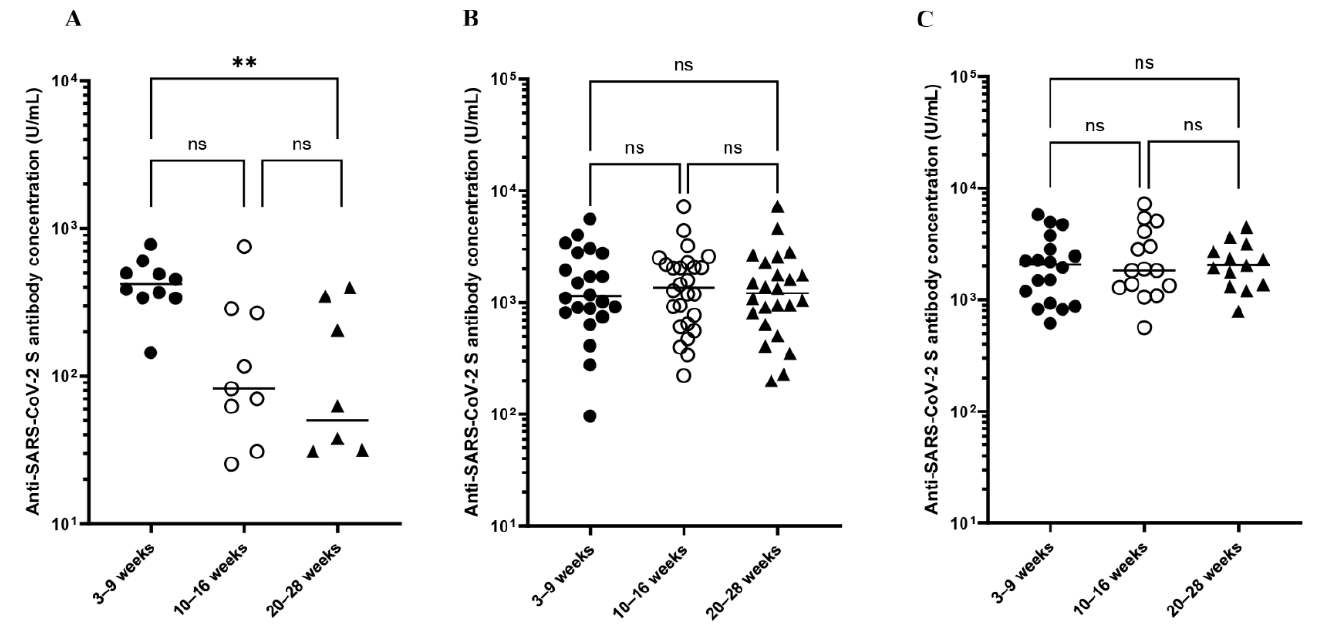
Figure 2. Anti-SARS-CoV-2 antibody concentrations (U/mL) at different time points after the initial two-vaccine series. ( A ) Antibody titers of patients treated with anti-TNF α decrease over time, and those at 20–28 weeks are significantly lower than those at 3–9 weeks. ( B ) Antibody titers of patients treated with non-anti-TNF α are sustained over time. ( C ) Antibody titers of PIBD patients treated with 5-ASA are sustained over time. TNF = tumor necrosis factor, 5-ASA = 5-aminosalicylic acid. For multiple comparisons, Brown-Forsythe and Welch analysis of variance followed by the Dunnett T3 correction was used, and -values < 0.05 were considered significant. ** indicates p -values < 0.01, and ns indicates not significant.